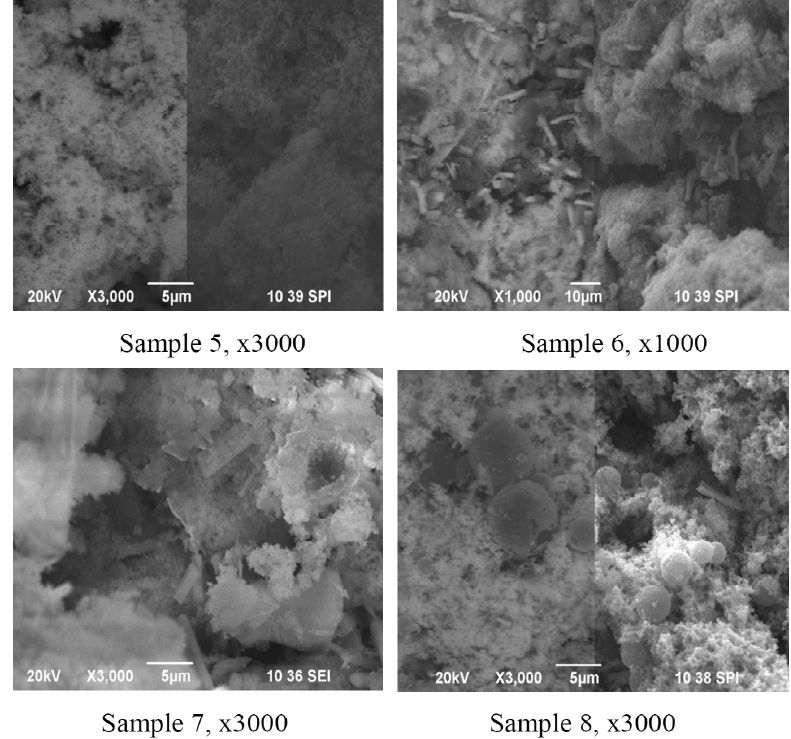
Fig. 2. SEM images at a different magnification of the samples synthesized at a ratio Ni:Sn=45:55: Sample 1-Ni-Sn nanoparticles, Sample 2-Ni-Sn nanoparticles/CF, Sample 3-Ni-Sn nanoparticles/CF and  -CDx, Sample 4-Ni-Sn nanoparticles/C-powder.